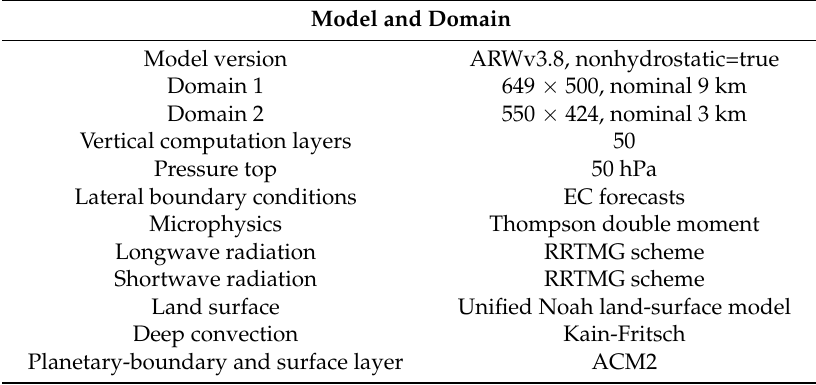
Table 1. Model and configurations of